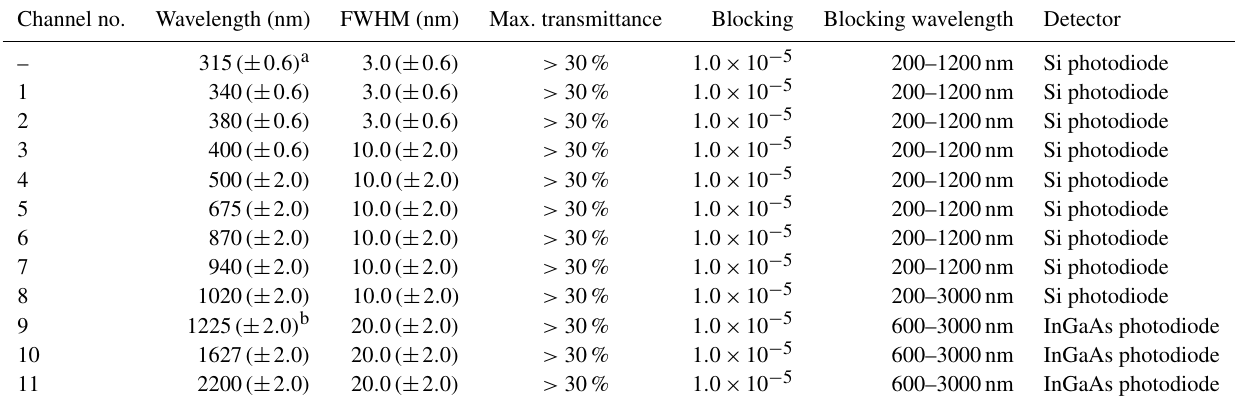
Table 1. Nominal filter specification. Channel